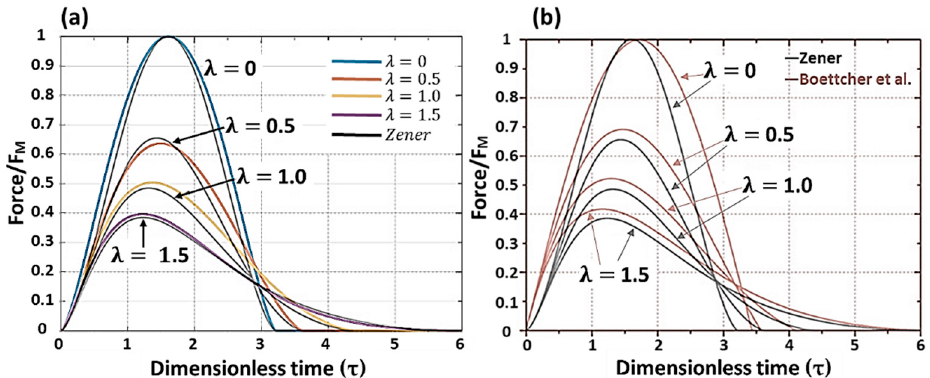
Figure 9. ( a ) Force–time collision curves of the equation established in this study and that of the Zener standard; ( b ) Force–time collision curves of the equations established by Boettcher et al. and Zener standard [2,12].